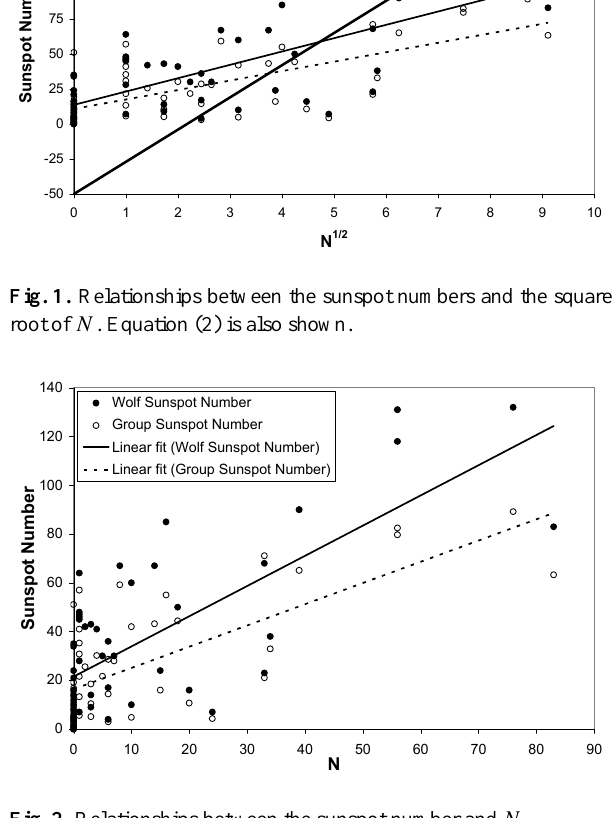
Table 1. The mean annual visual observations of the auroras N at the middle latitudes of Europe provided by Schr¨oder et al. (2004) and mean annual levels of the solar activity ( R Z , Wolf sunspot num- ber; R G , Group sunspot number) during 1780–1829.